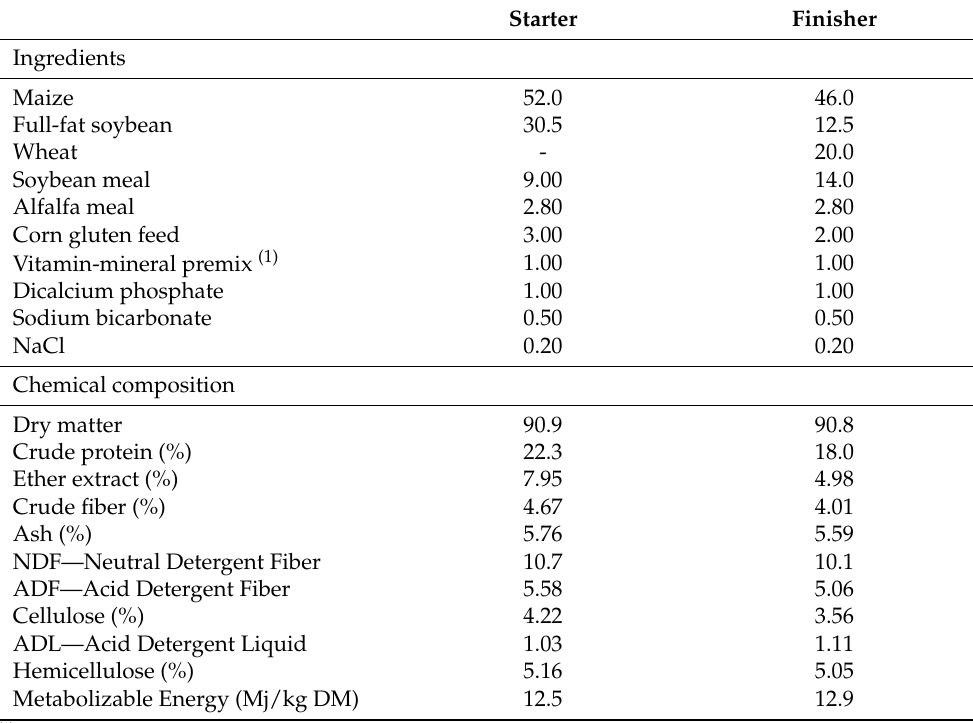
Table 1. Ingredient composition and calculated analysis of